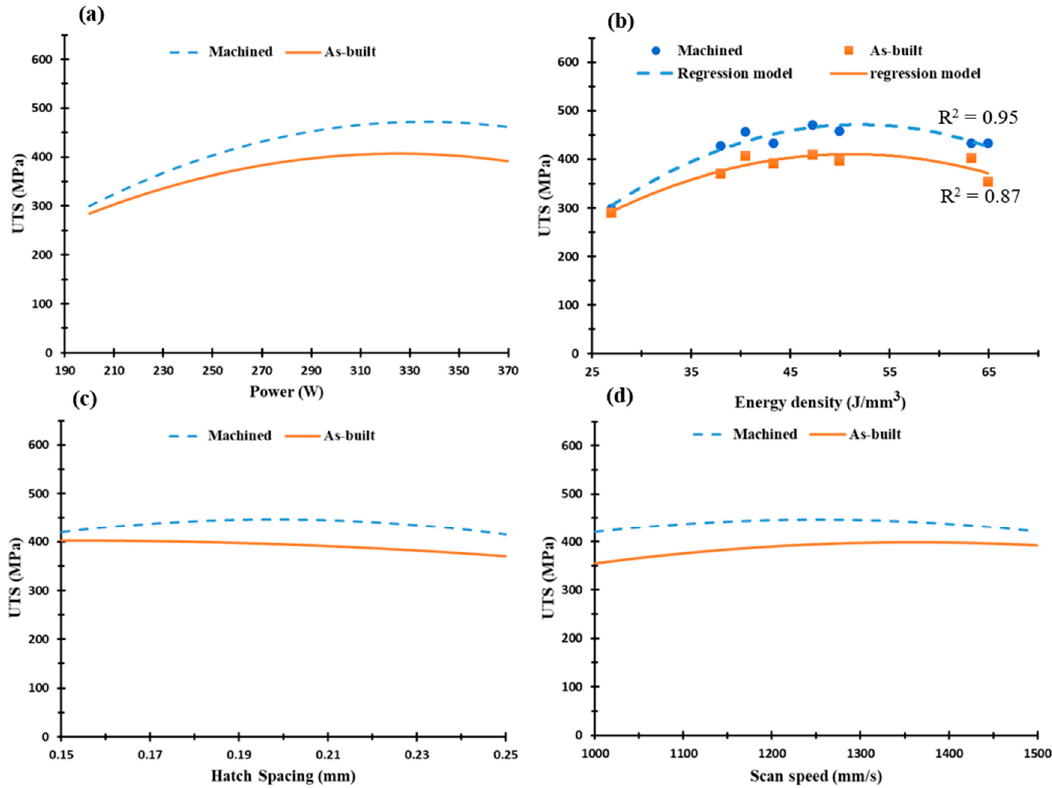
Figure 14. Ultimate tensile strength of the as-built AlSi10Mg samples along the building direction vs. ( a ) Laser power (W); ( b ) Energy density (J/mm 3 ), ( c ) Hatch Spacing (mm), and ( d ) Scan speed